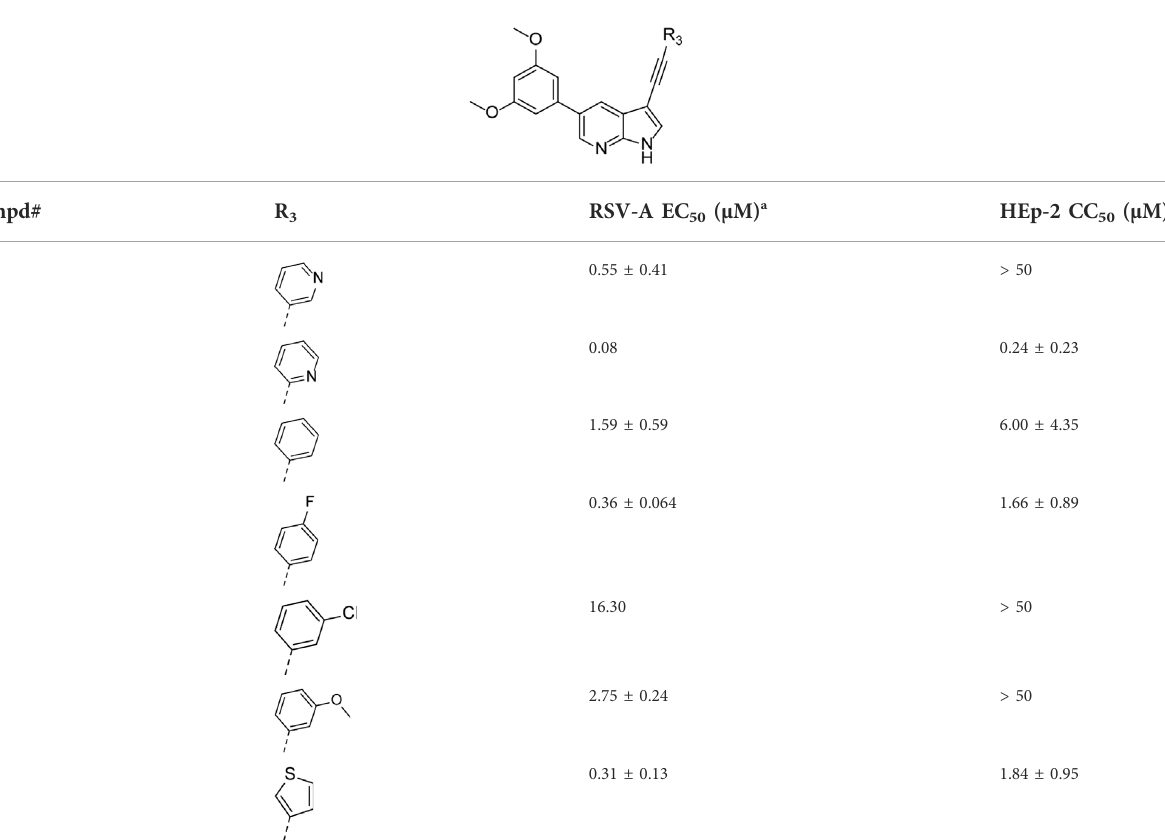
TABLE 3 Anti-RSV activity and cytotoxicity of 5-(2,5-dimethoxy)-3-alkynyl-pyrrolo[2,3- b ]pyridines